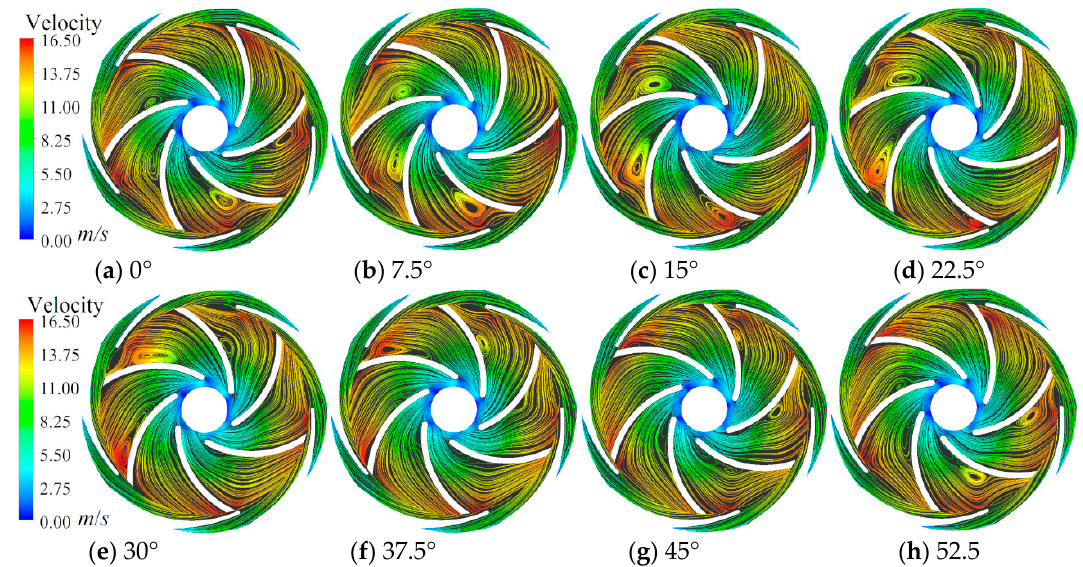
Figure 13. Evolution processes of the vortices in the stator and rotor cascade during a 1/6 period of impeller rotation under condition 1.0 Q d .